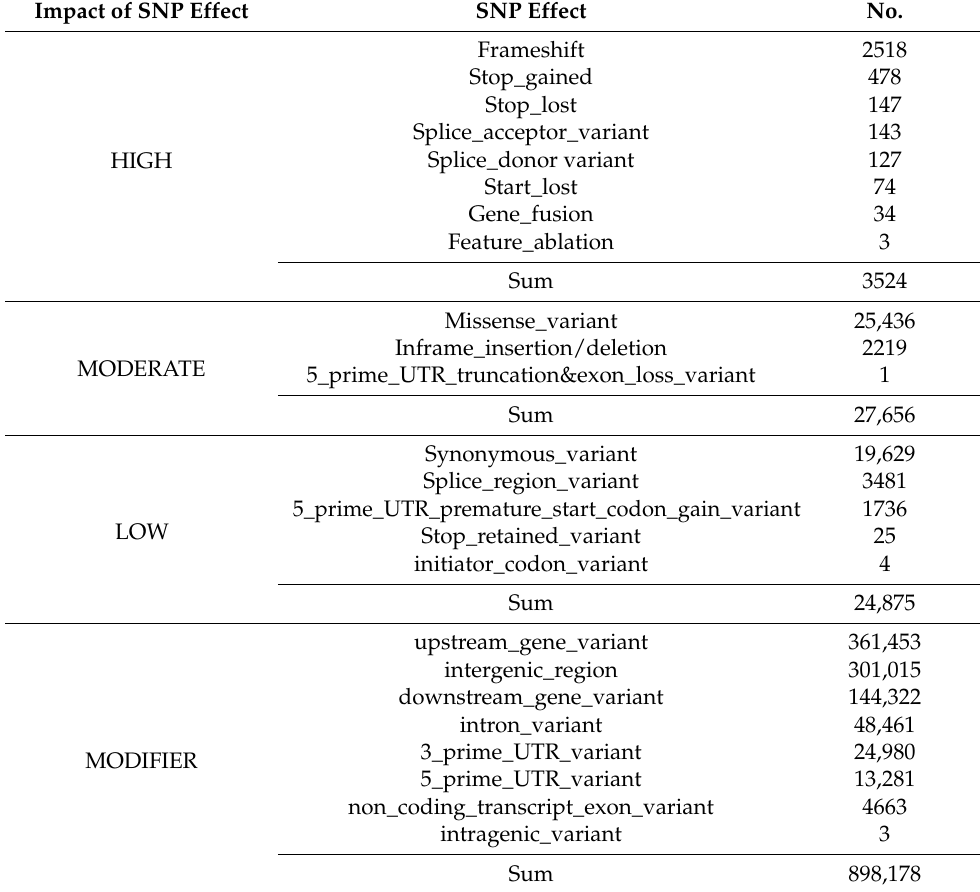
Table 3. Classification of variants by their